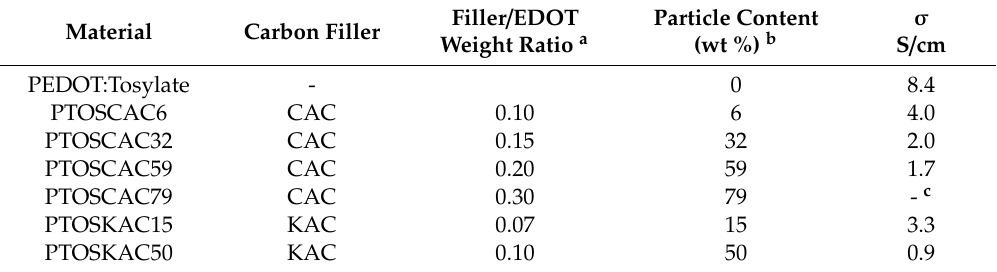
Table 1. Characteristics of PEDOT-AC composite materials